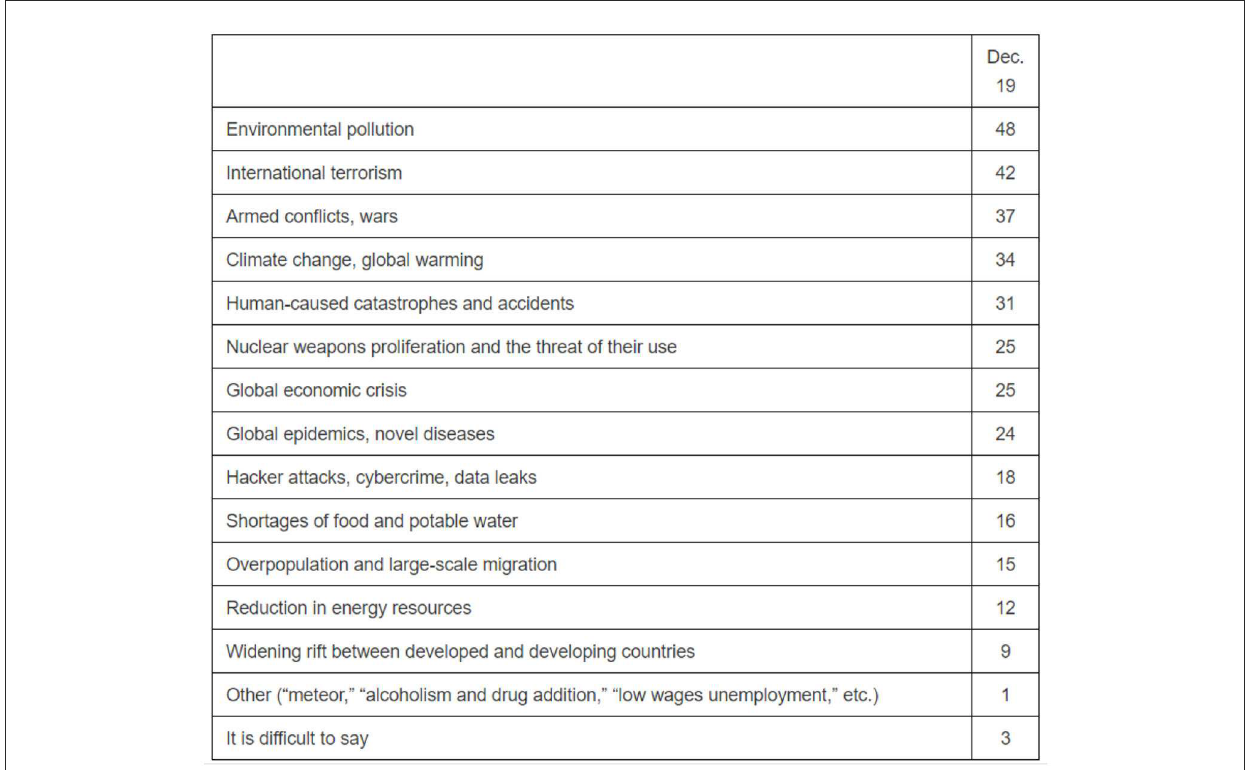
FIGURE8 Levada-Center, From Opinion to Understanding, Environmental problems in Russia. Russians believe that environmental pollution is a major threat to their lives and put climate change and global warming at the 4th place after terrorism, 2nd place, and war, 3rd. Available online at: https://www. levada.ru/en/2020/02/18/environmental-problems/ (accessed February 23,